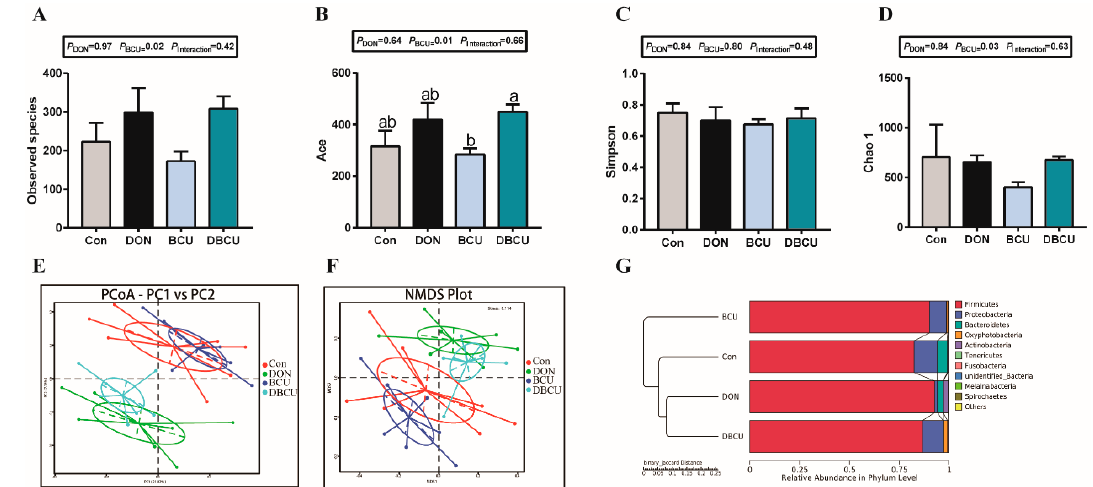
Figure 2. Effects of dietary DON and BCU on gut microbiota diversity in piglets. ( A ) Observed species; ( B ) Shannon H index; ( C ) Chao 1 index; ( D ) Ace index. ( E ) Principal coordinates analysis (PCoA) of intestinal microbiomes (binary Jaccard). ( F ) Nonmetric multidimensional scaling (NMDS) of intestinal microbiomes (binary Jaccard). ( G ) Comparison of binary Jaccard between pairs of samples. ( A – D ) Values are means ± SEMs, n = 7. Different letters in the picture represent differences, p < 0.05. Basal diet (Con); 4 mg DON/kg diet (DON); 5 g BCU/kg diet (BCU); 5 g BCU/kg with 4 mg DON/kg diet (DBCU).